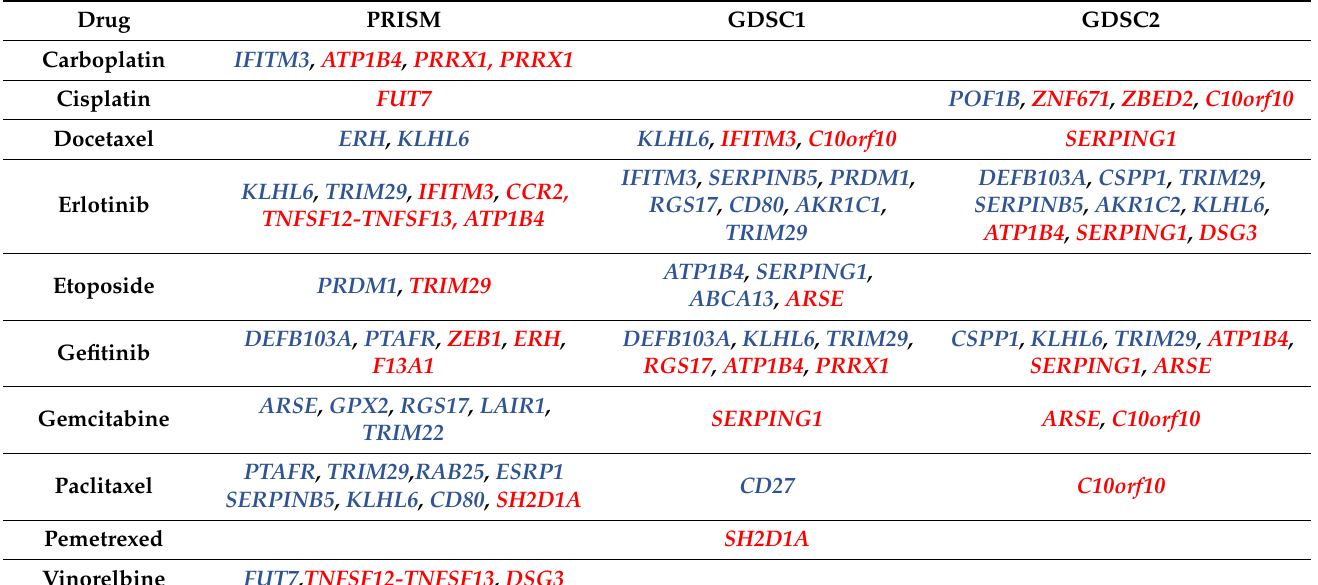
Table 1. Genes (shown in Figure 1C) with a significant differential mRNA expression ( p < 0.05; two sample t -tests) and a fold change < 0.5 or >2 in sensitive versus resistant CCLE NSCLC cell lines ( n = 117) to the studied drugs. Blue font indicates higher mRNA expression in sensitive cell lines, and red font indicates high mRNA expression in resistant cell lines.